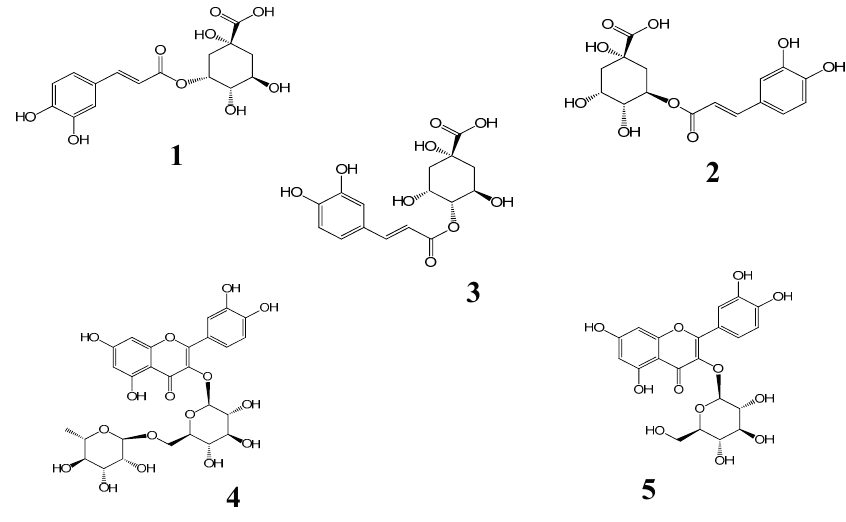
Figure 3. Chemical structures of the five investigated compounds including